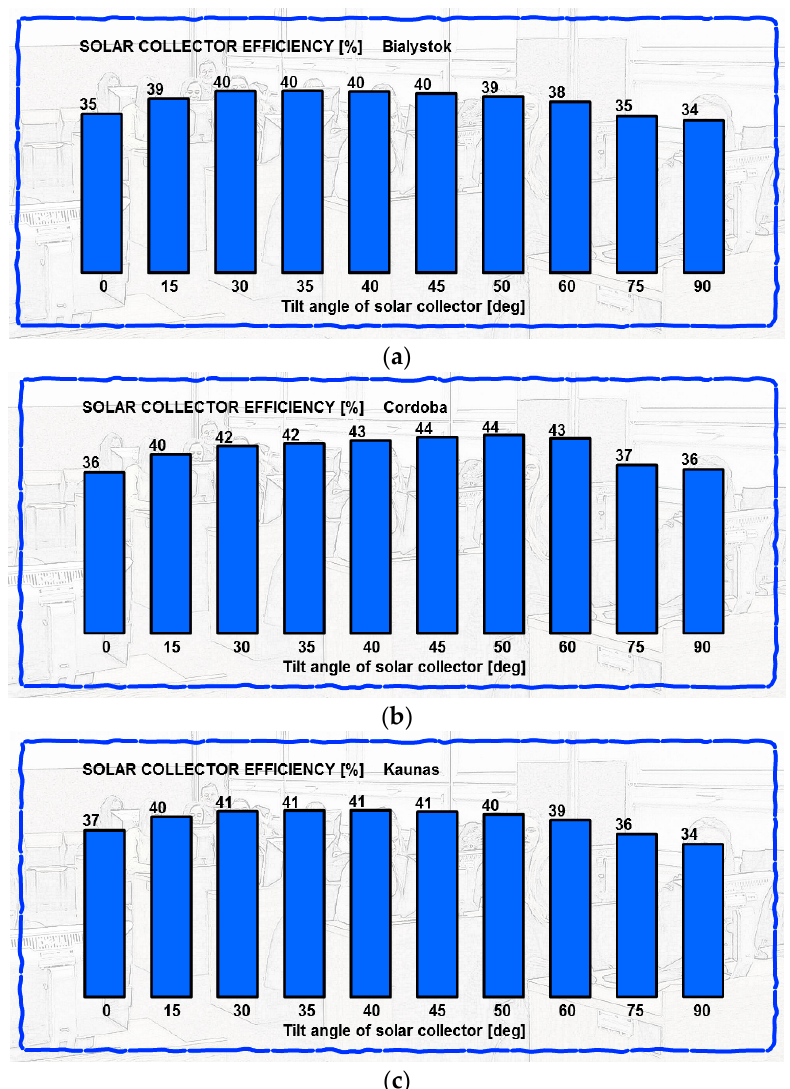
Figure 3. Efficiency of solar collectors in Bialystok ( a ), Cordoba ( b ) and Kaunas ( c ) in dependence on the tilt angle—drawn upon VIPSKILLS tools